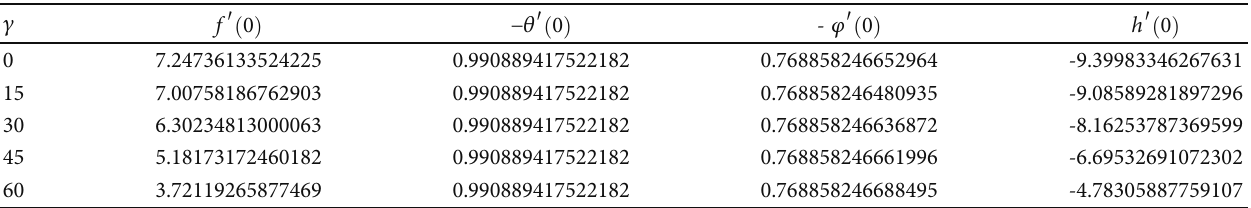
Table 5: Values of skin friction coe ffi cient, heat transfer and mass transfer for inclined angle variation with M =2, c =0.5, Pr